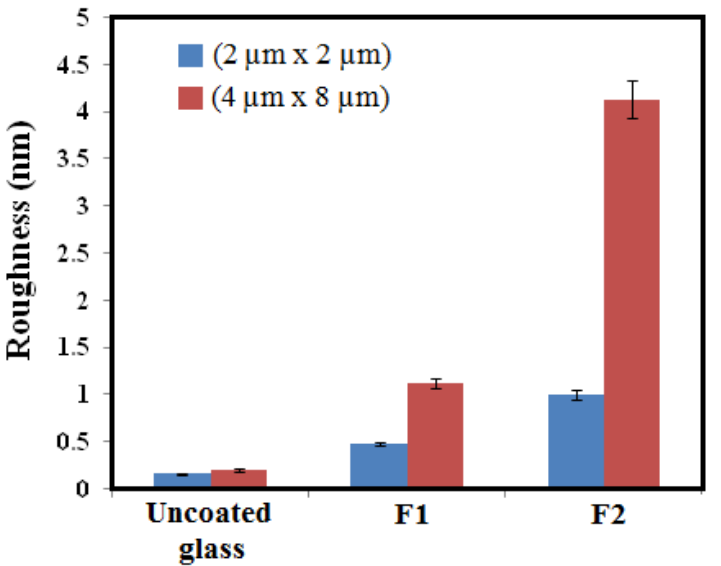
Figure 7. Root-mean-square roughness for the uncoated glass and the fluorinated hybrid coatings (TEOS/MTES/FS (F1) and TEOS/MTES/HDTMES/FS (F2)), at the scales of 2 µm × 2 µm, and 4 µm × 8 µm.